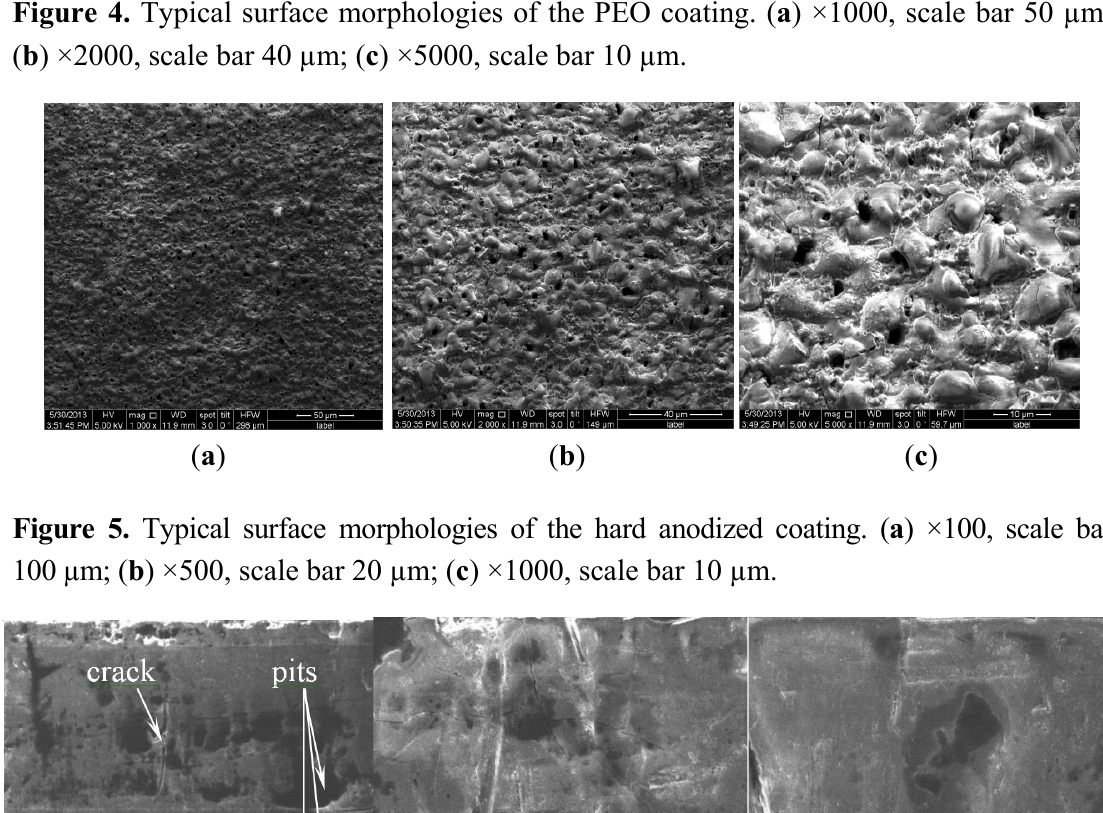
Figure 4. Typical surface morphologies of the PEO coating. ( a ) ×1000, scale bar 50 µm;